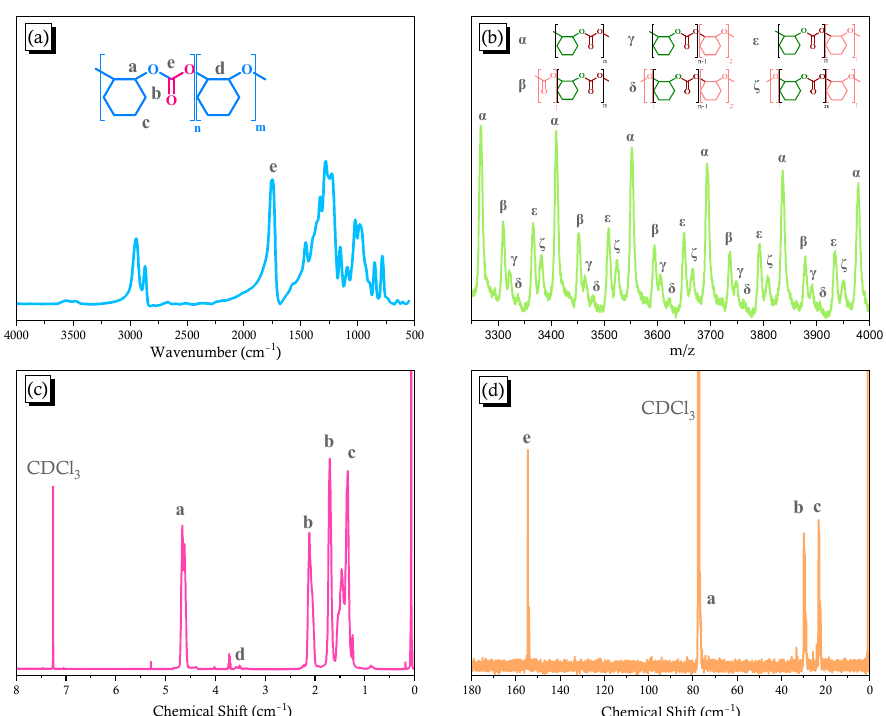
Figure 1. ( a ) Synthesis of the PCHC copolymer and its FTIR, ( b ) MALDI-TOF mass, ( c ) 1 H NMR, and ( d ) 13 C NMR spectra.